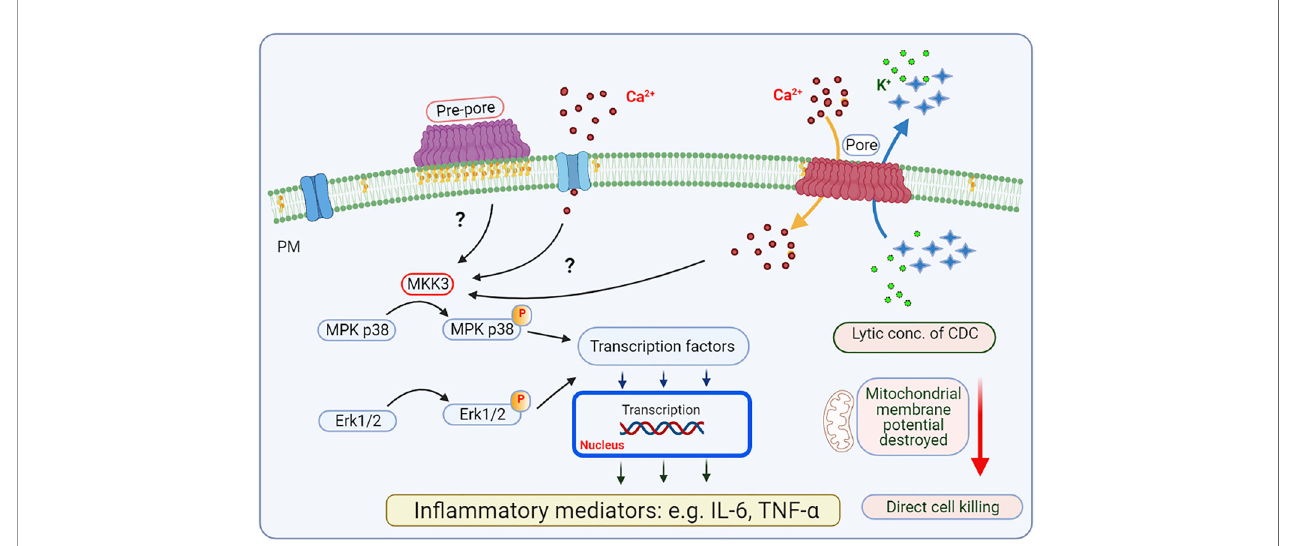
FIGURE 4 | Mast cell activation by CDCs - de novo production of in fl ammatory mediators. Among proteins phosphorylated and activated by CDC-induced changes is mitogen-activated protein kinase (MPK)3, which is involved in phosphorylation and activation of MPK p38 and Erk1/2. These enzymes are involved in activation of transcription factors regulating transcription of selected genes for in fl ammatory cytokines and chemokines (e.g., IL-6 and TNF- a ). It is not clear whether CDCs at the pre-pore stage have any role in these signaling events. Higher concentrations of CDCs lead to killing of target cells in the absence of production of in fl ammatory